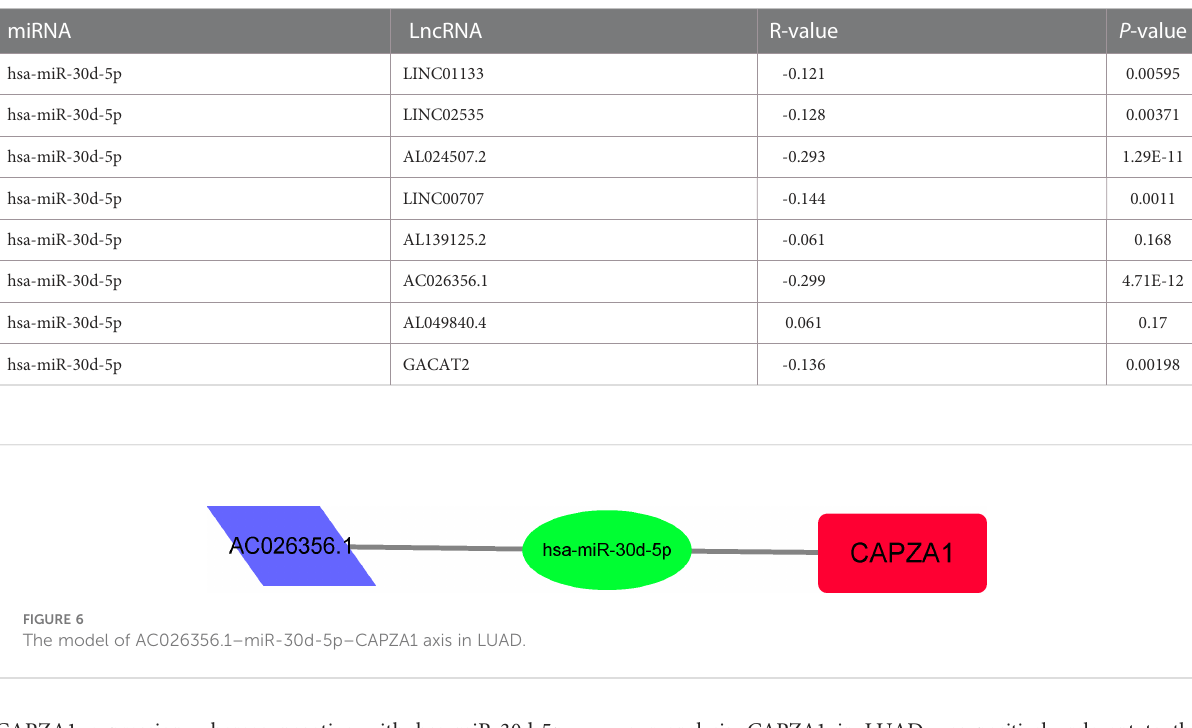
TABLE 3 The correlation between mir and lncRNA in lung adenocarcinoma.